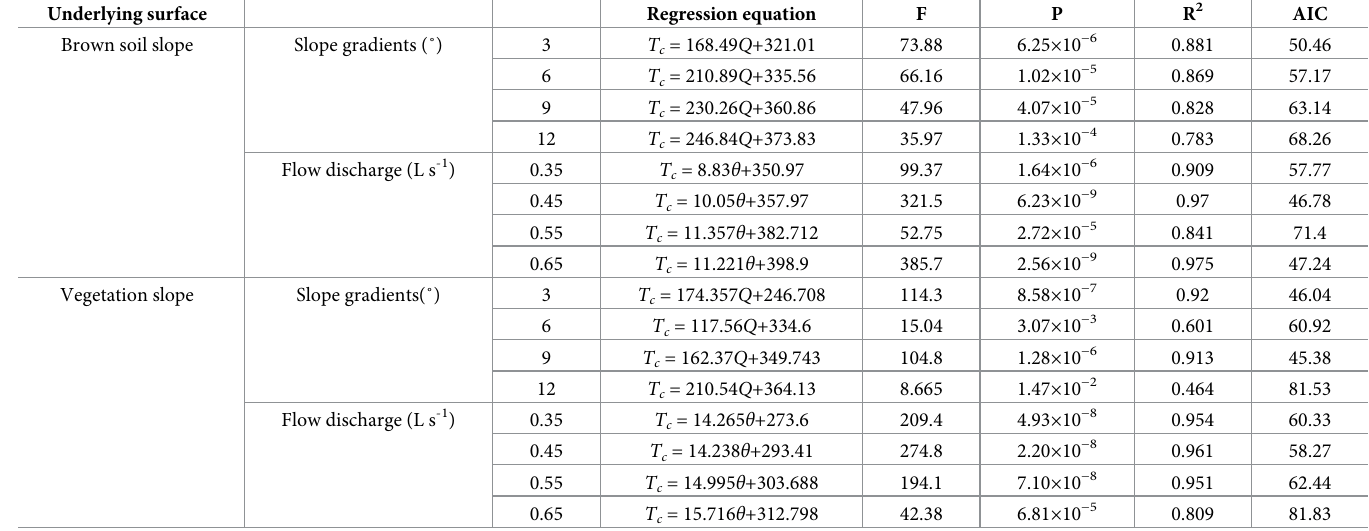
Table 4. Regression equation between slope gradients ( θ ), flow discharge ( Q ), and sediment transport capacity ( T c ), respectively. Underlying surface